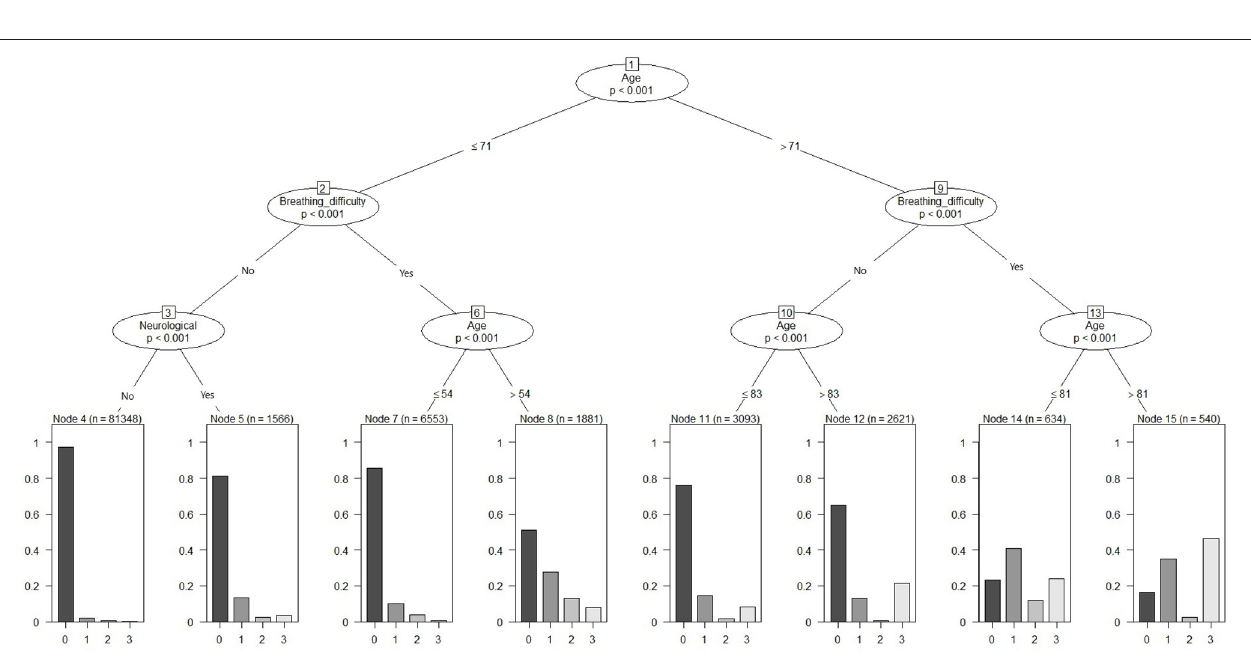
FIGURE 2 | Pruned conditional inference decision tree for classifying severe outcomes (hospitalization, ICU admission or death) among COVID-19.